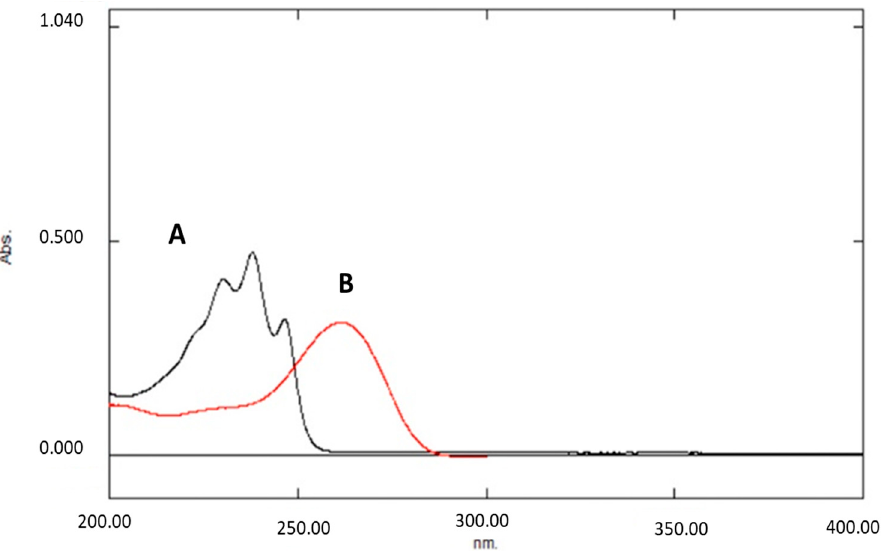
Figure 3. Lovastatin absorption peaks at 232, 238, and 247 nm ( A ) and ergothioneine absorption peak at 260 nm ( B ).